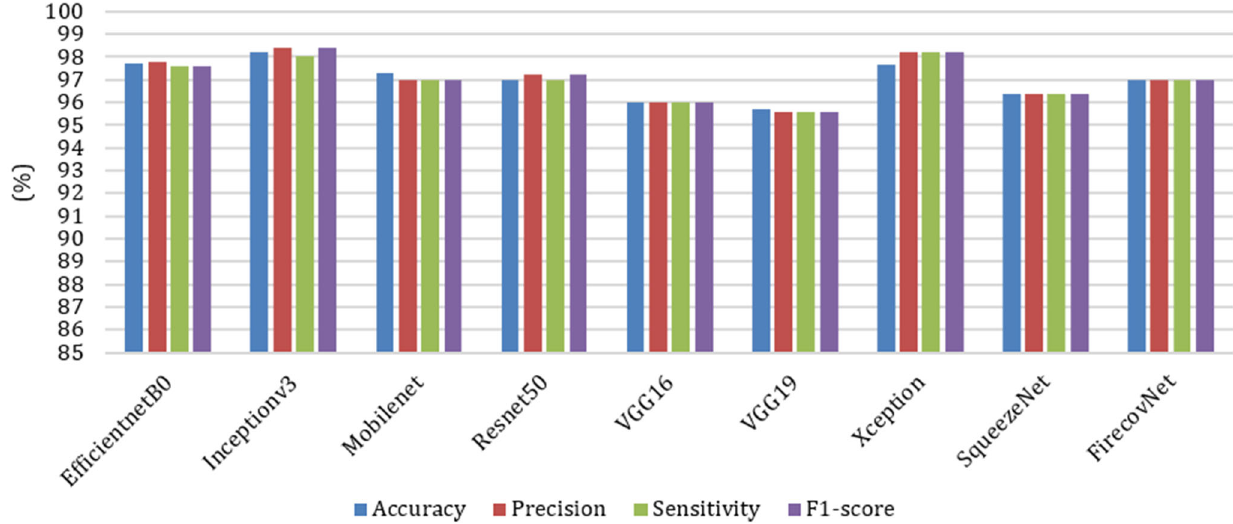
Figure 9. Running time for FirecovNet comparison with eight networks for 5 ‐ class classification in 50 epochs.